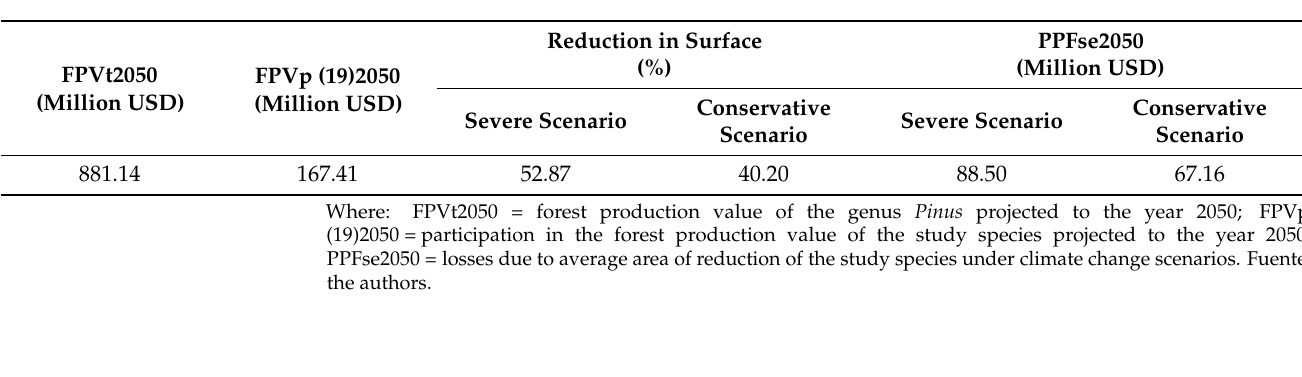
Forest production value of the genus Pinus and the study species under climate change